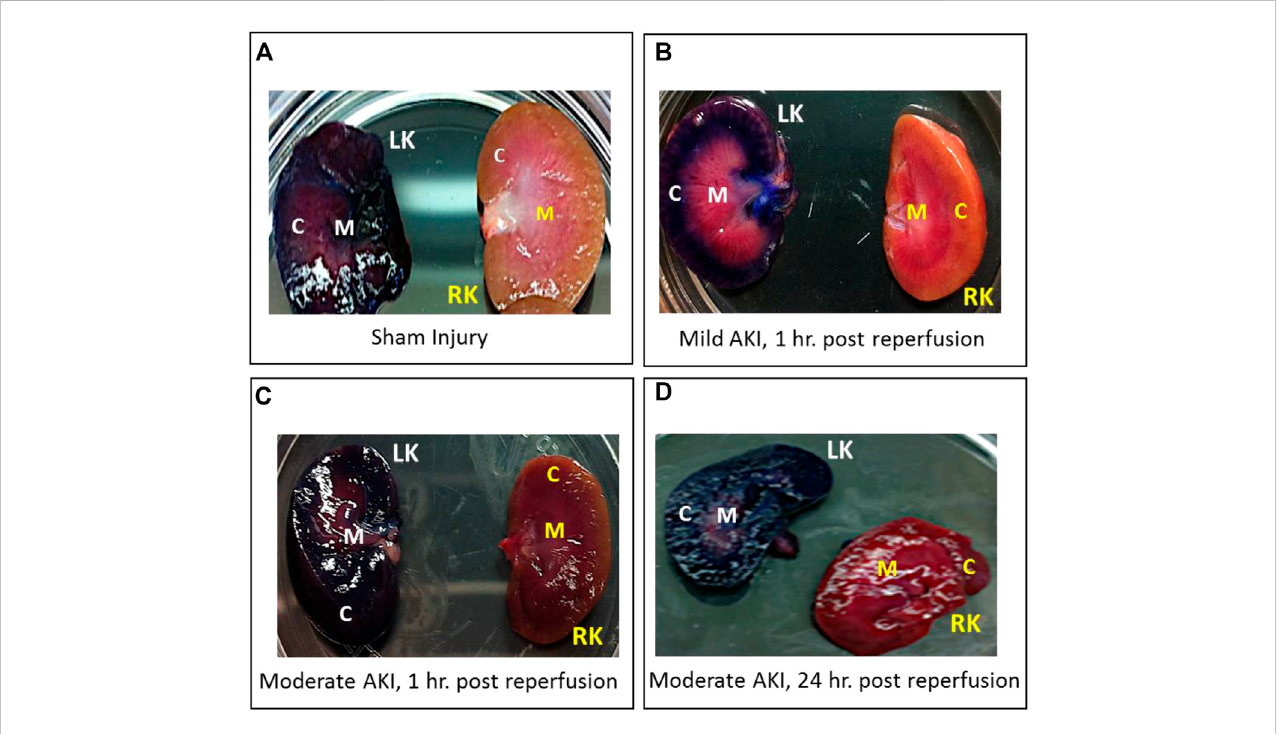
FIGURE 2 Digital photographs were used to illustrate the localized and widespread delivery resulting from renal vein hydrodynamic injections performed in (A) Sham injured rats and those with (B) mild AKI (injectionsperformed 1 hafter inducing AKI), (C) moderate AKI (injections performed 1 hafter inducing AKI), and (D) moderateAKI (injectionsperformed 24 h after inducing AKI).These kidneys were harvested and sectioned within 20 min of performing theinjections. The dye appeared throughout the cortex and medulla of the left kidneys and was absent in the contralateral kidneys. LK = left kidney, RK = right kidney, C = cortex, and M =